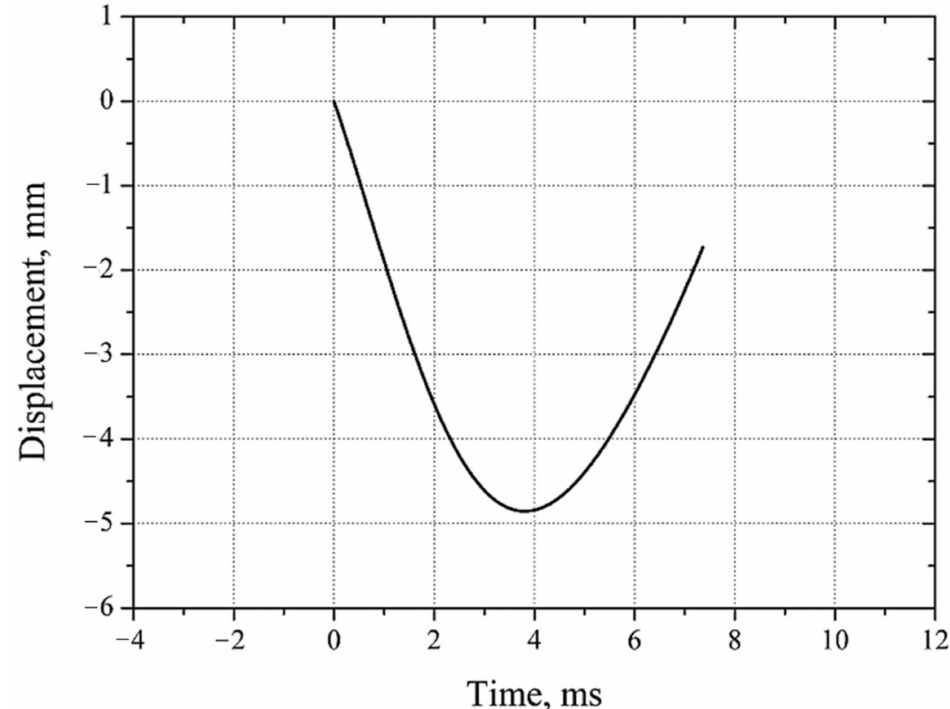
Figure 19. Displacement during the impact test on LC–DP